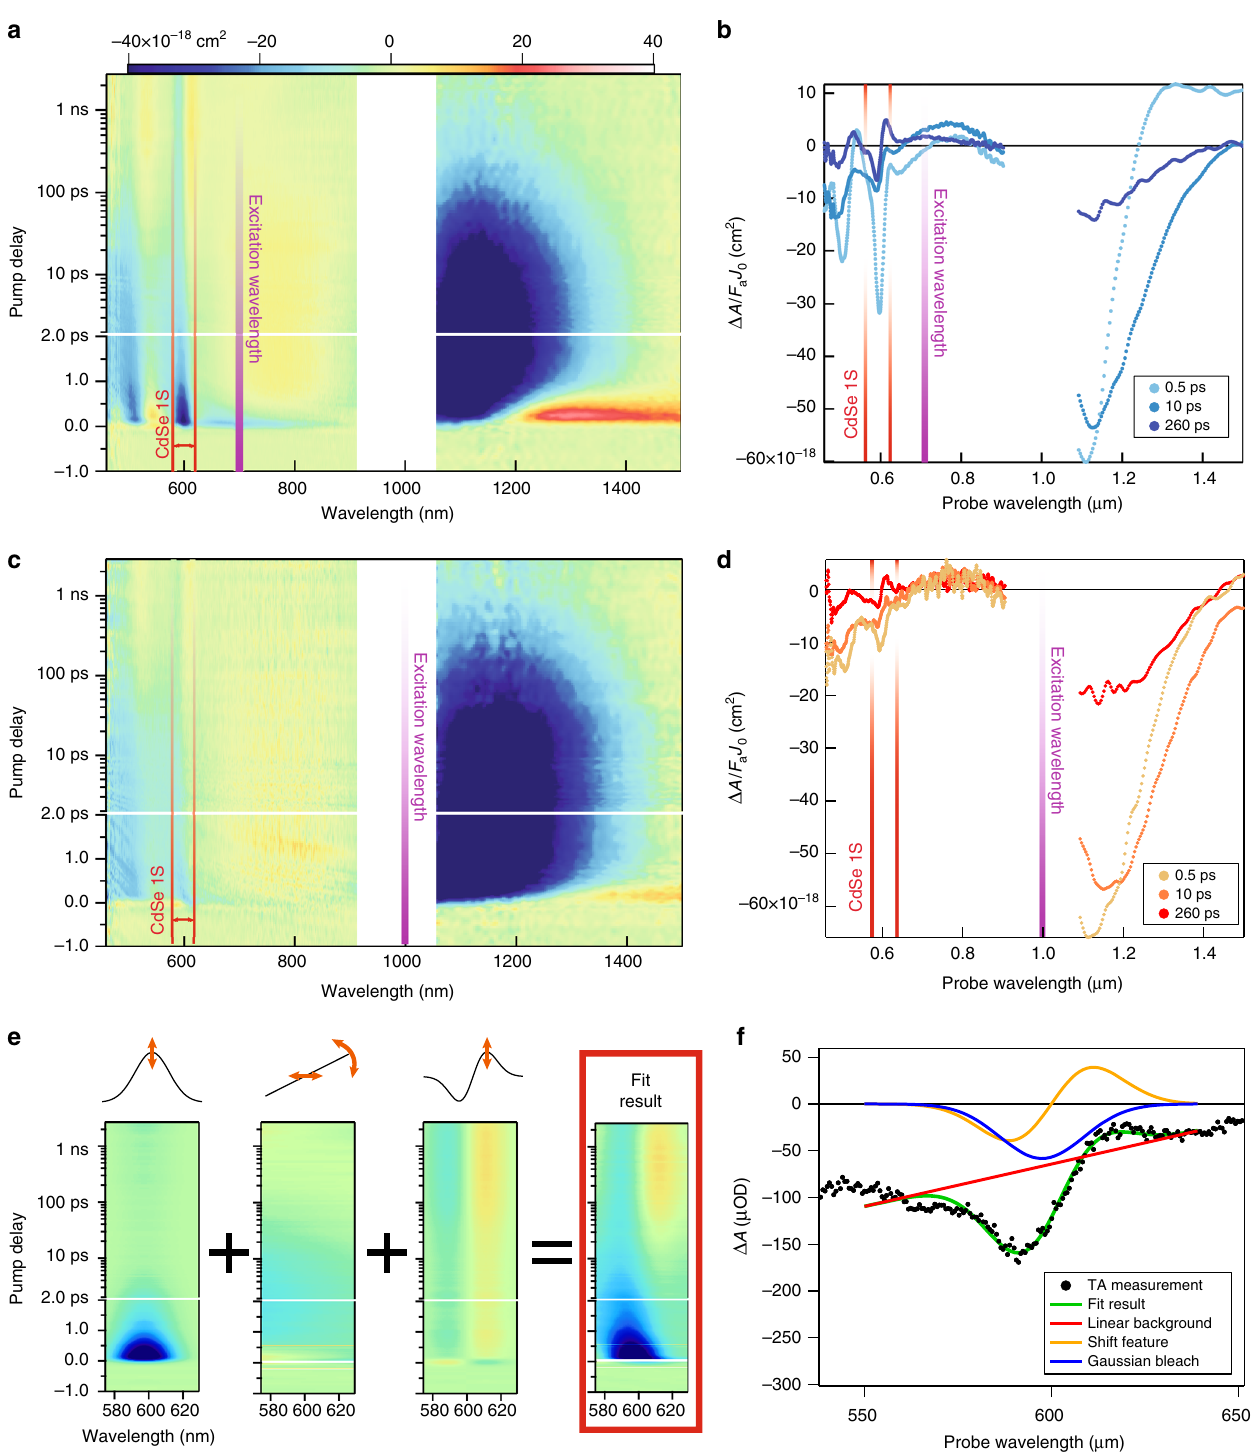
Fig. 3 Heterojunction- fi lm transient absorption response for different excitations and fi tting method. a Transient absorption (TA) color map showing the differential absorbance per absorbed fl uence of the combined PbSe-CdSe fi lm, photoexcited at 700 nm with an absorbed fl uence of 1.4 × 10 13 photons/cm 2 x pulse (0.36 excitons per PbSe QD). b Spectral slices of the color map 3a. c TA color map of the combined fi lm photoexcited at 1000nm with an absorbed fl uence of 3.4 (3.0) × 10 13 photons/cm 2 x pulse in the visible (NIR) range (~0.07 excitons per PbSe QD). d Spectral cuts of color map 3c. e Color maps showing the different contributions to the fi t of the TA response around the CdSe 1S feature; i.e. a Gaussian bleach, a linear background and a shift feature, as described in the text. The orange arrows in the schematics represent the 4 fi t parameters (see Supplementary Note 6). f Spectral slice of a TA measurement showing the agreement between fi t and experimental trace, together with the shape of the different